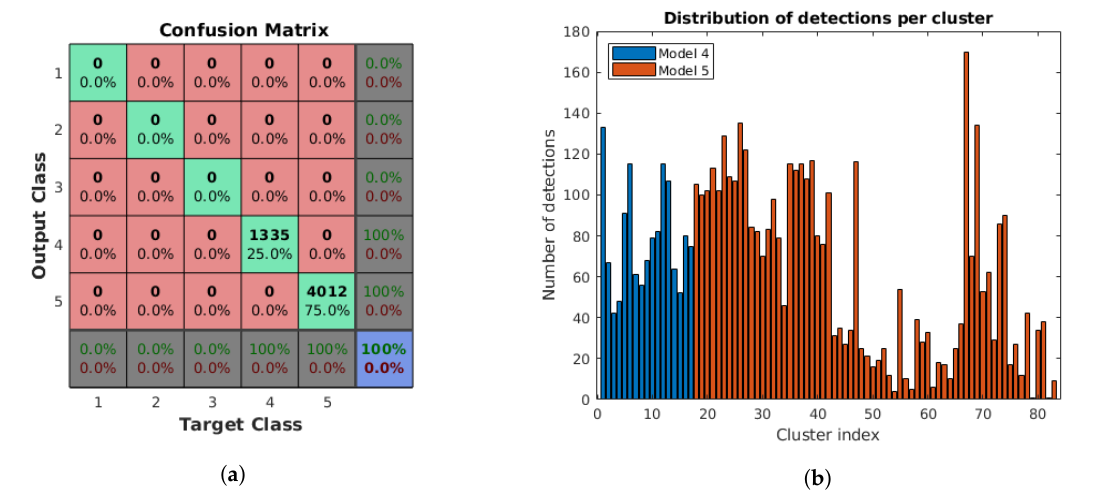
Figure 10. Results of the identification and clustering procedure. All detections were correctly classified, with neither incorrect detections of the three old models (Models 1, 2 and 3) nor errors between Models 4 and 5: ( a ) confusion matrix for the five lamp models used in the experiments; and ( b ) distribution of detections per cluster for each lamp model. Average number of elements: 78.53 for Model 4, 60.79 for Model 5, and 64.42 for all clusters.